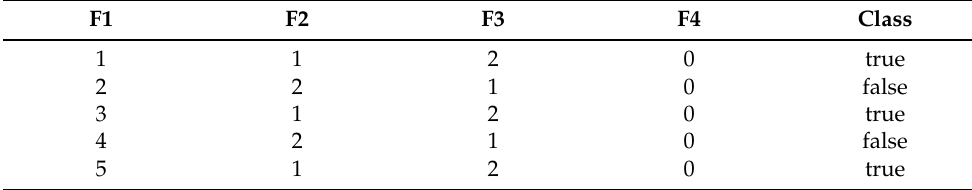
Table 3. Robustness artificial dataset